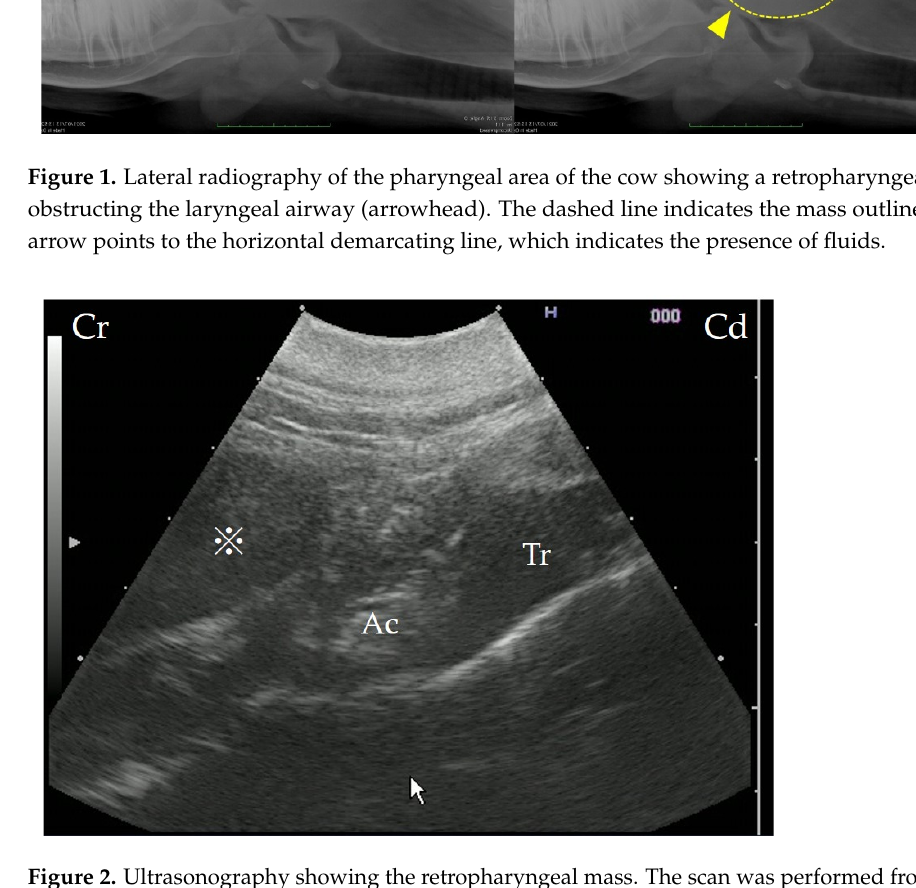
Figure 1. Lateral radiography of the pharyngeal area of the cow showing a retropharyngeal abscess obstructing the laryngeal airway (arrowhead). The dashed line indicates the mass outline, and the arrow points to the horizontal demarcating line, which indicates the presence of fluids.